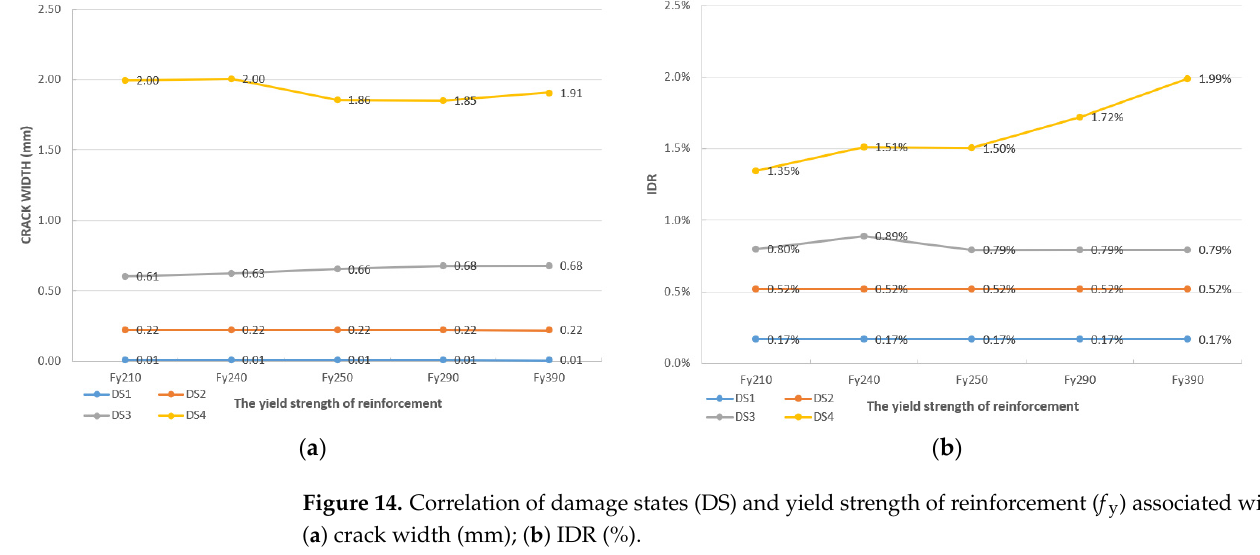
Figure 13. Correlation of damage states (DS) and the ratio of reinforcement ( ρ ) associated with: ( a ) crack width (mm); ( b ) IDR (%).